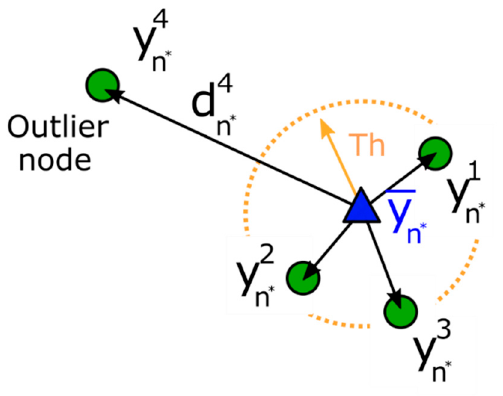
= n* and M = 4. Th indicates the